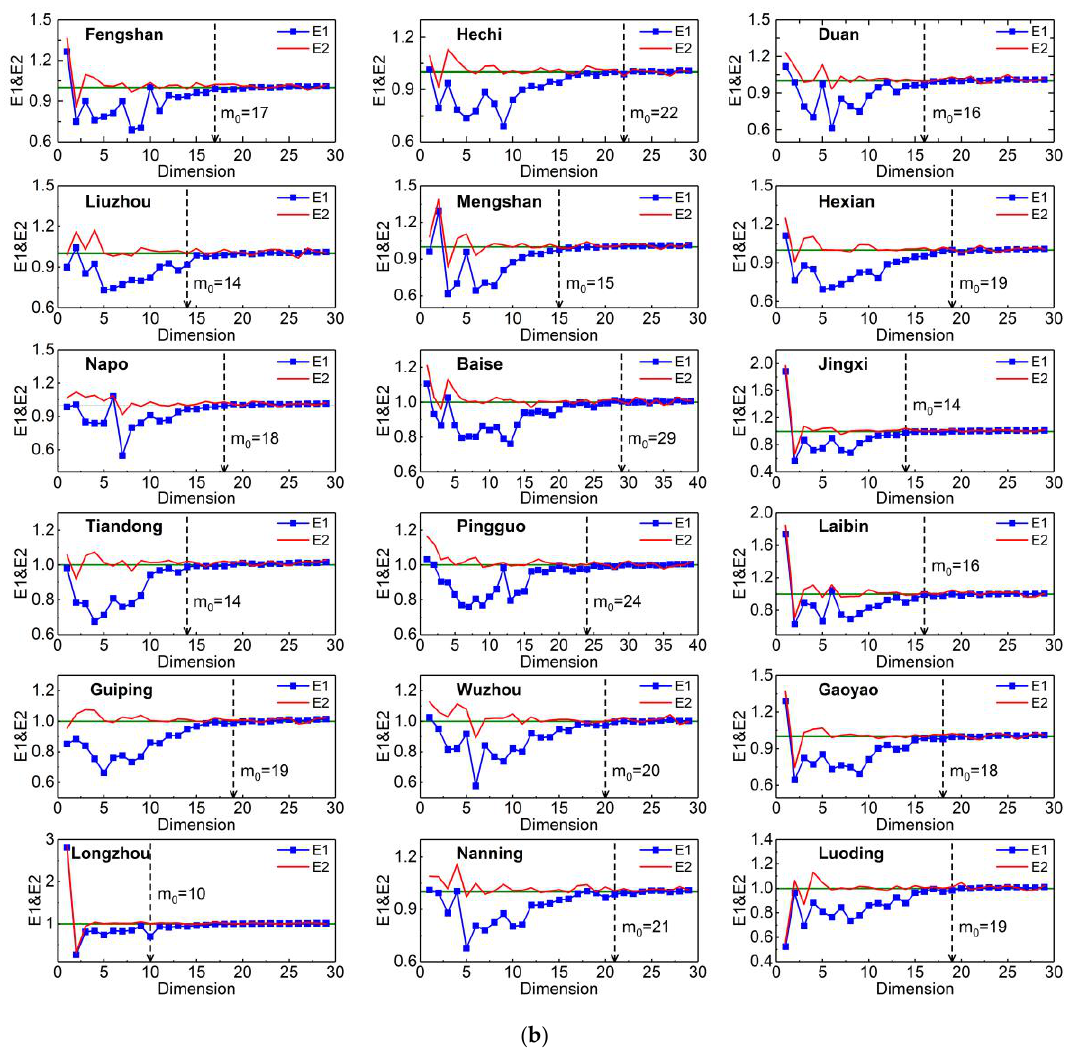
Figure 10. ( a ) E 1 and E 2 curves of 36 meteorological stations in the Xijiang River Basin calculated by the Cao method. m 0 is the critical point of steady change. ( b ) E 1 and E 2 curves of 36 meteorological stations in the Xijiang River Basin calculated by Cao method. m 0 is the minimum embedding dimension.